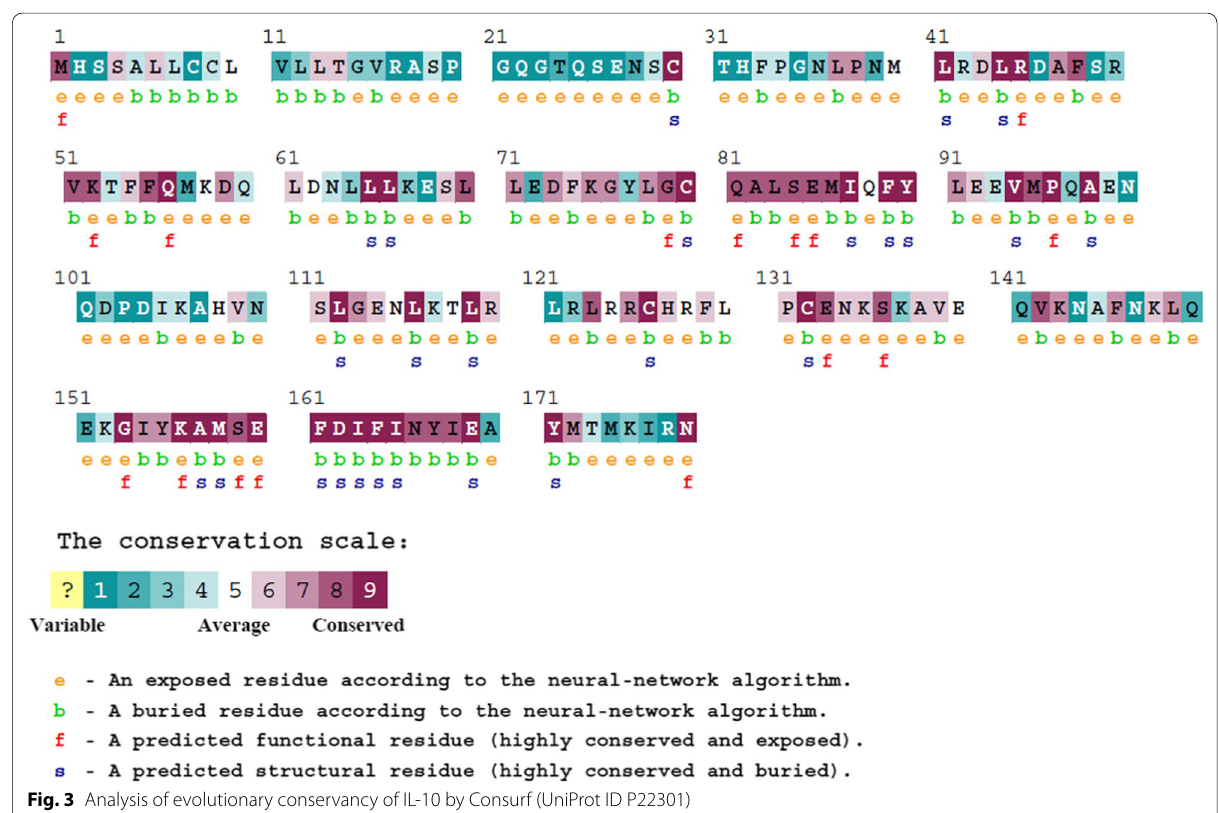
Fig. 3 Analysis of evolutionary conservancy of IL-10 by Consurf (UniProt ID